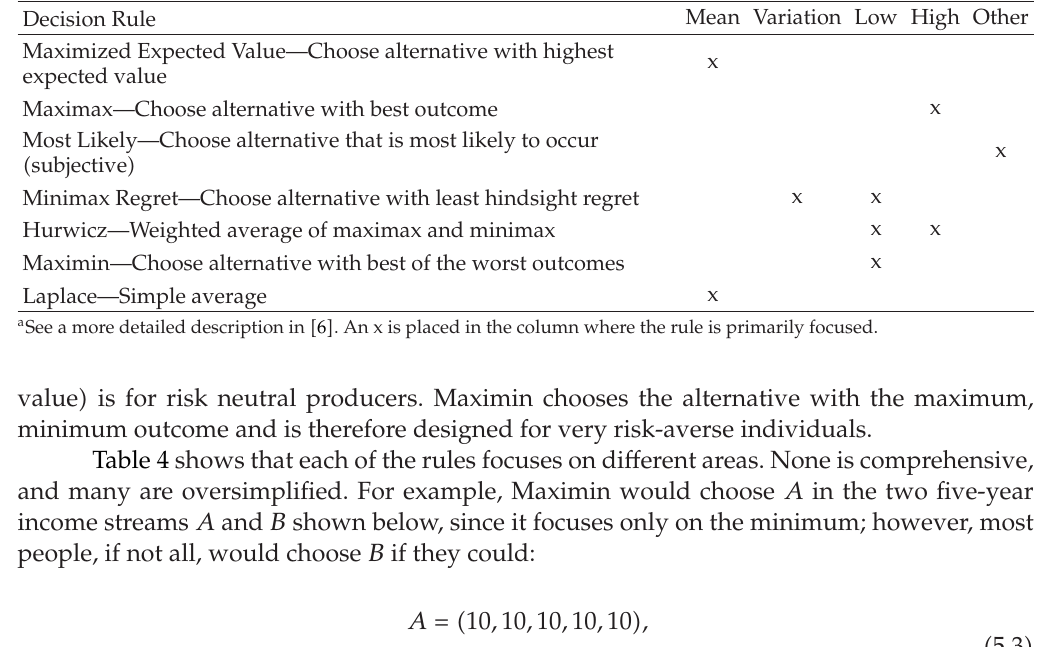
Figure 5: Risk Ranker—compare profiles—see source in (cid:4) 6 (cid:5) . Table 4: Attributes of basic decision rules a